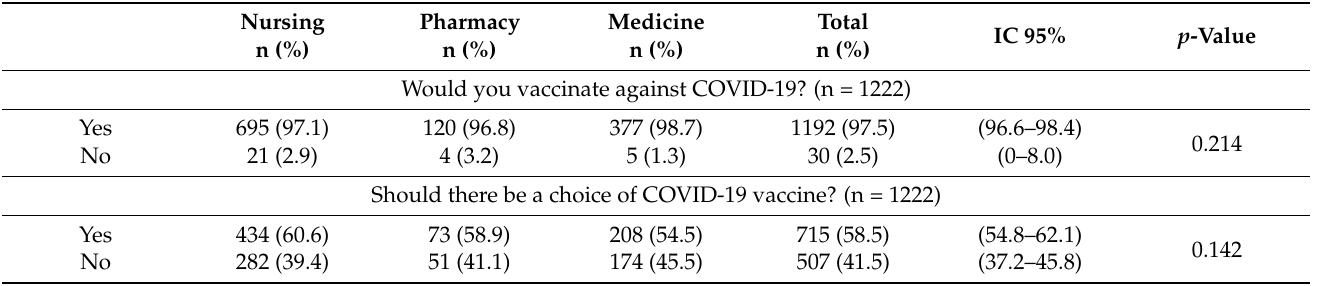
Table 3. Acceptance of the COVID-19 vaccine and attitude towards vaccination. (n =